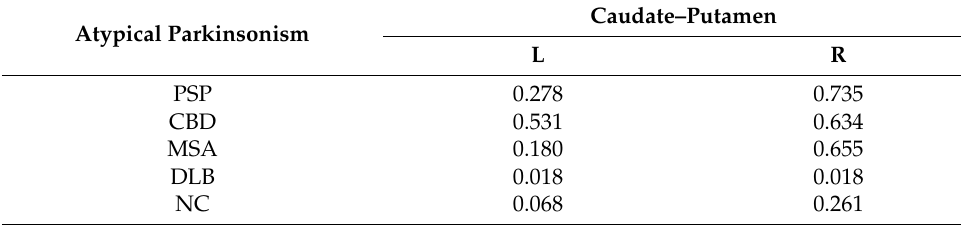
Table 6. Differences between caudate and putamen in atypical parkinsonisms ( p -values). Atypical